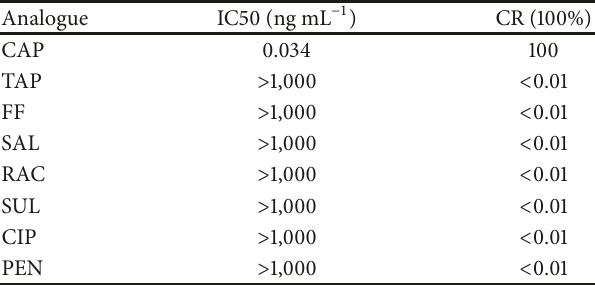
Table 1: IC50 and cross-reactivity (CR) value of CAP analogues.